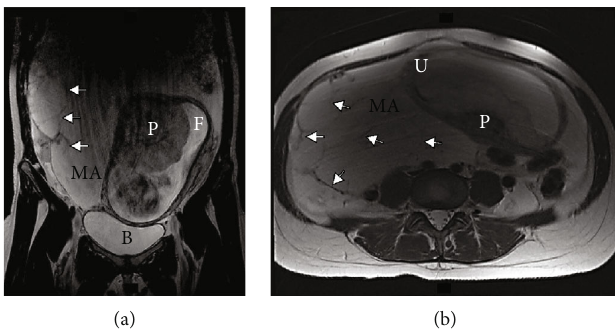
Figure 2: (a), (b) Abdominal and pelvic MRI without IV contrast ((a) coronal plane, (b) axial plane) shows a gravid uterus and signi fi cant amount of T2 hyperintense fl uid, some of which is loculated with internal septations (arrows). B: bladder; F: fetus; IV: intravenous; MA: mucinous ascites; MRI: magnetic resonance imaging; P: placenta; U: